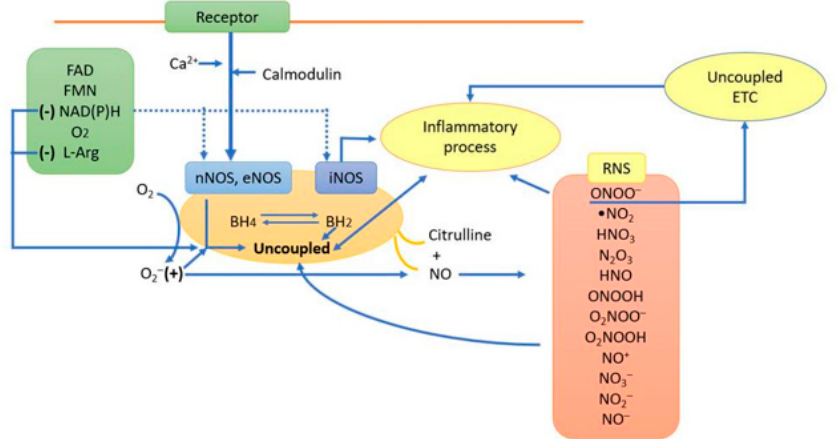
Figure 1. Interrelationship between the synthesis of nitric oxide and the generation of RNS. The RNS are formed in the presence of high O 2 concentrations—and when there is an abnormal increase in the level of NO produced by the iNOS and / or by the uncoupled eNOS and nNOS. Abbreviations: FAD = flavin adenine dinucleotide, FMN = flavin mononucleotide, NAD(P)H = nicotinamide adenine dinucleotide, O 2 = molecular oxygen, RNS = reactive nitrogen species, NO = nitric oxide, ONOO − = peroxynitrate, •NO 2 = nitrogen dioxide, HNO 3 = peroxynitrous acid, N 2 O 3 = dinitrogen trioxide, HNO = nitroxyl, ONOOH = peroxynitrous acid, O 2 NOO − = peroxynitrate, O 2 NOOH = peroxynitric acid, NO + = nitrosonium cation, NO 3 − = nitrate, NO 2 − = nitrite, NO − = nitroxyl anion, RNS = reactive nitrogen species, ETC = electron transport chain, BH4 = tetrahydrobiopterin, BH2 = dihydrobiopterin and L- arg = L -arginine. nNOS, eNOS and iNOS = neuronal, endothelial and inducible nitric oxide synthase.